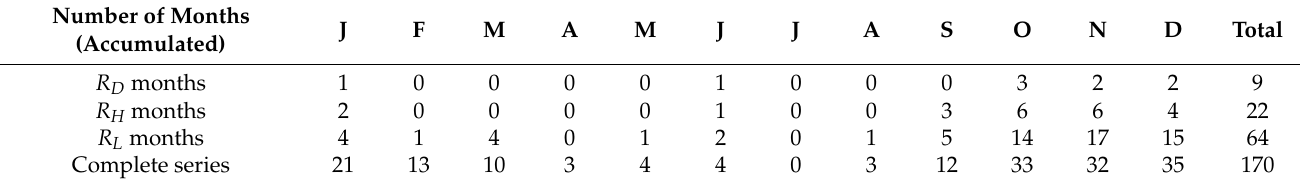
Table 1. Monthly distribution of the annual maximum daily precipitation ( P MD ) in which at least the three risk levels indicated are